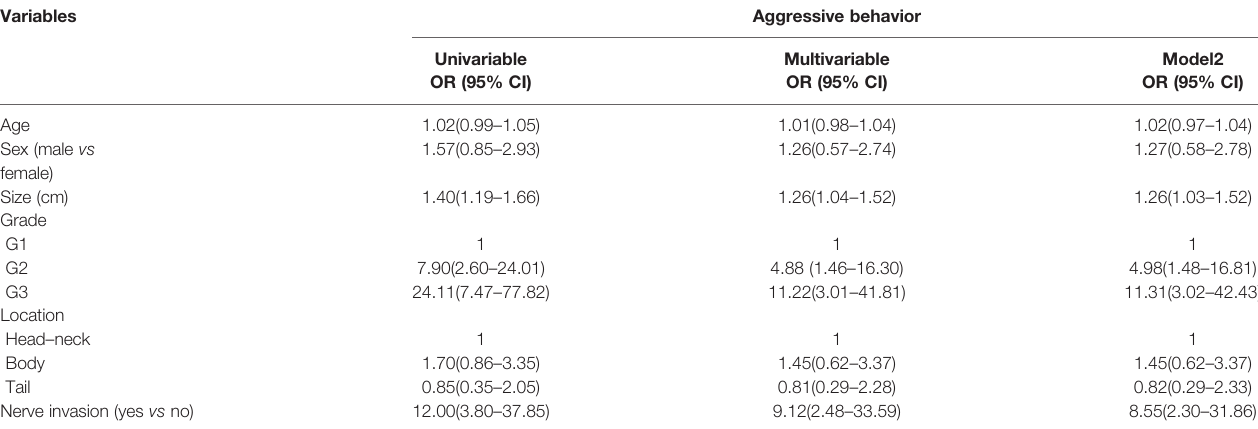
TABLE 2 | Logistic regression analysis in total population.